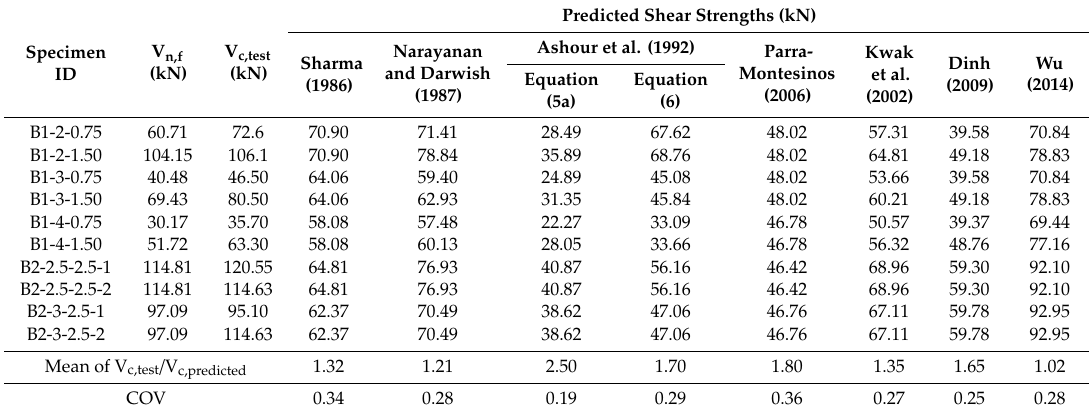
Table 6. Comparison between measured and predicted